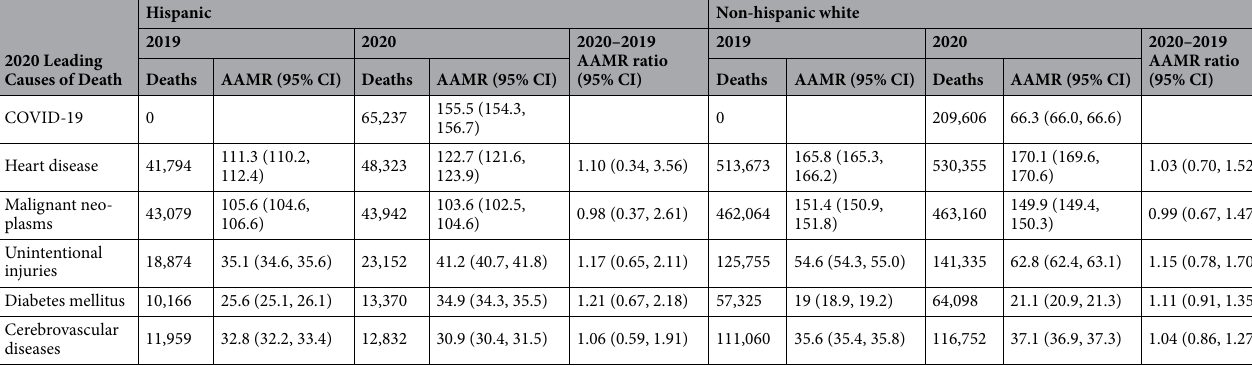
Table 1. Cause-specific Hispanic and Non-Hispanic White age-adjusted mortality in the US, 2019–2020. Abbreviations: AAMR age-adjusted mortality rate, deaths per 100,000 individuals, CI confidence interval, COVID-19 Coronavirus Disease 2019.